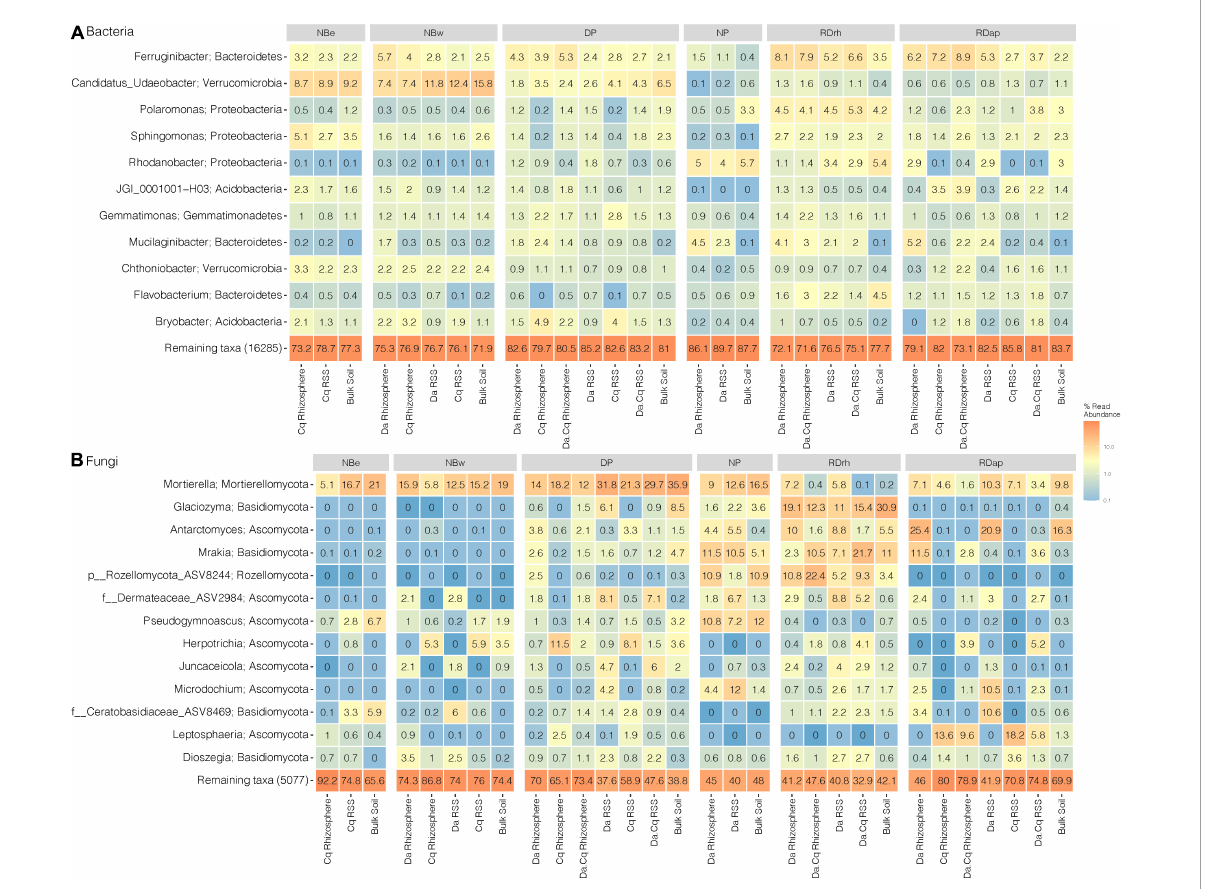
association Da.Cq mainly were composed of site-specific